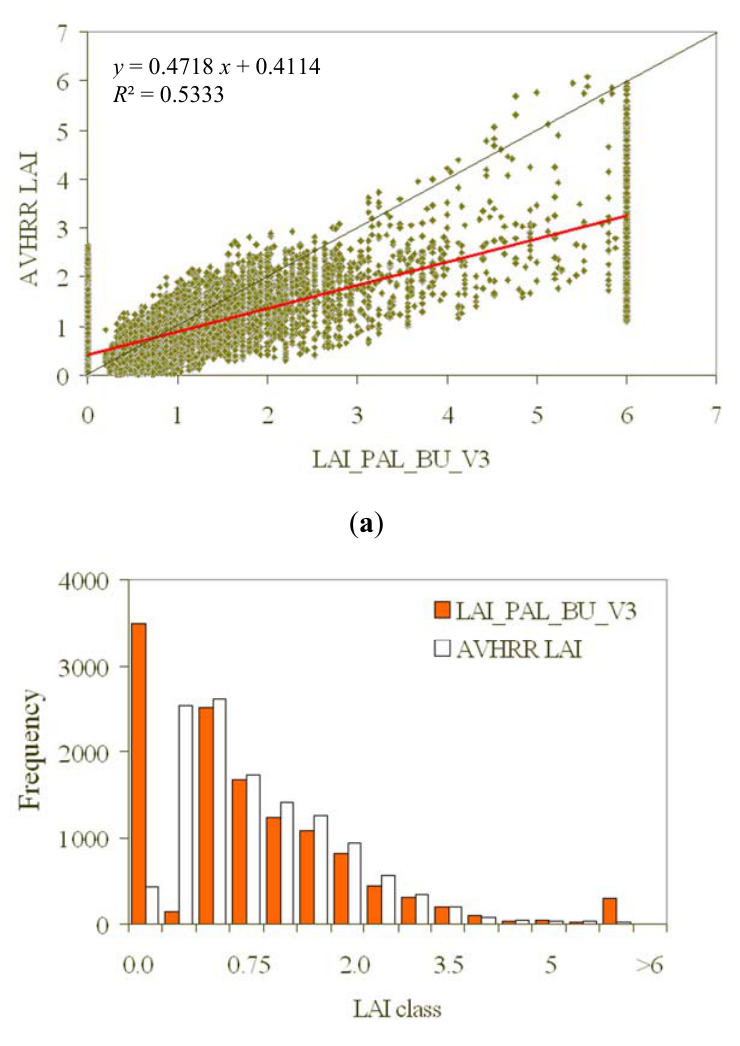
y = 0.4718 x + 0.4114 R ² =